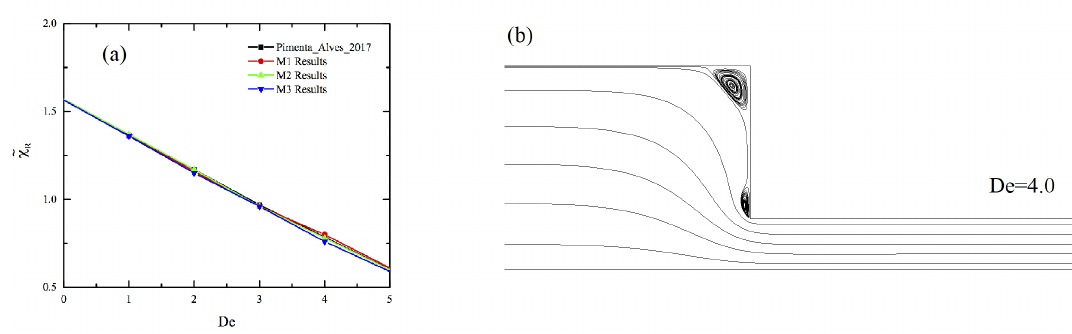
Figure 2. Solution of Oldroyd-B model for 4:1 contraction: ( a ) size of dimensionless corner vortex for different Deborah numbers and ( b ) streamlines at De = 4 and Re = 0.01. The results are compared with those of Pimenta and Alves [30] for